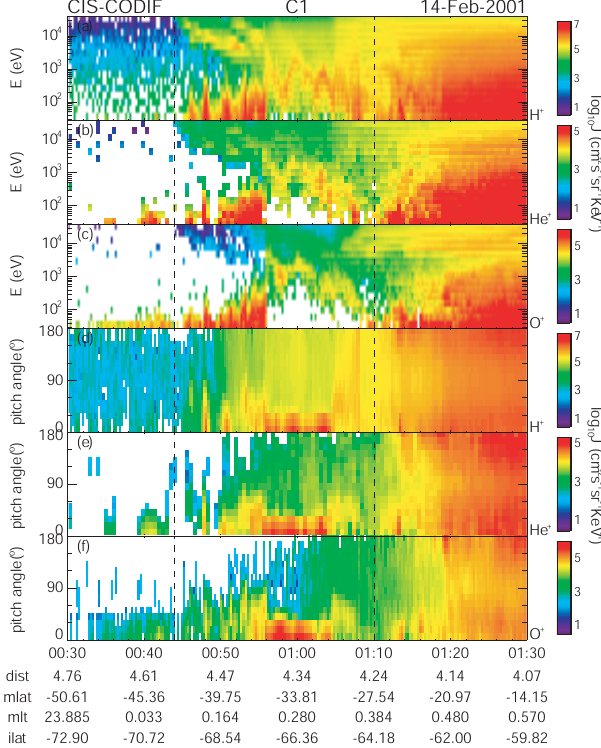
Figure 1. A summary plot of the ion measurements on Cluster 1. Panels (a) – (c) show the differential number flux spectrogram of H + , He + , and O + , while panels (d) – (f) show the pitch-angle distri- butions of these ions. The inverted-V features appeared sporadically in all ion species. The position of the spacecraft is shown at the bot- tom. The spacecraft was traversing the Southern Hemisphere just after local